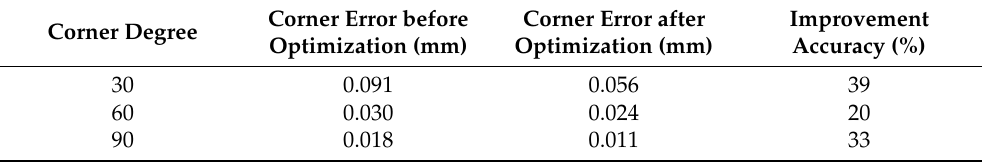
Table 15. Comparison of corner error values before and after optimization of